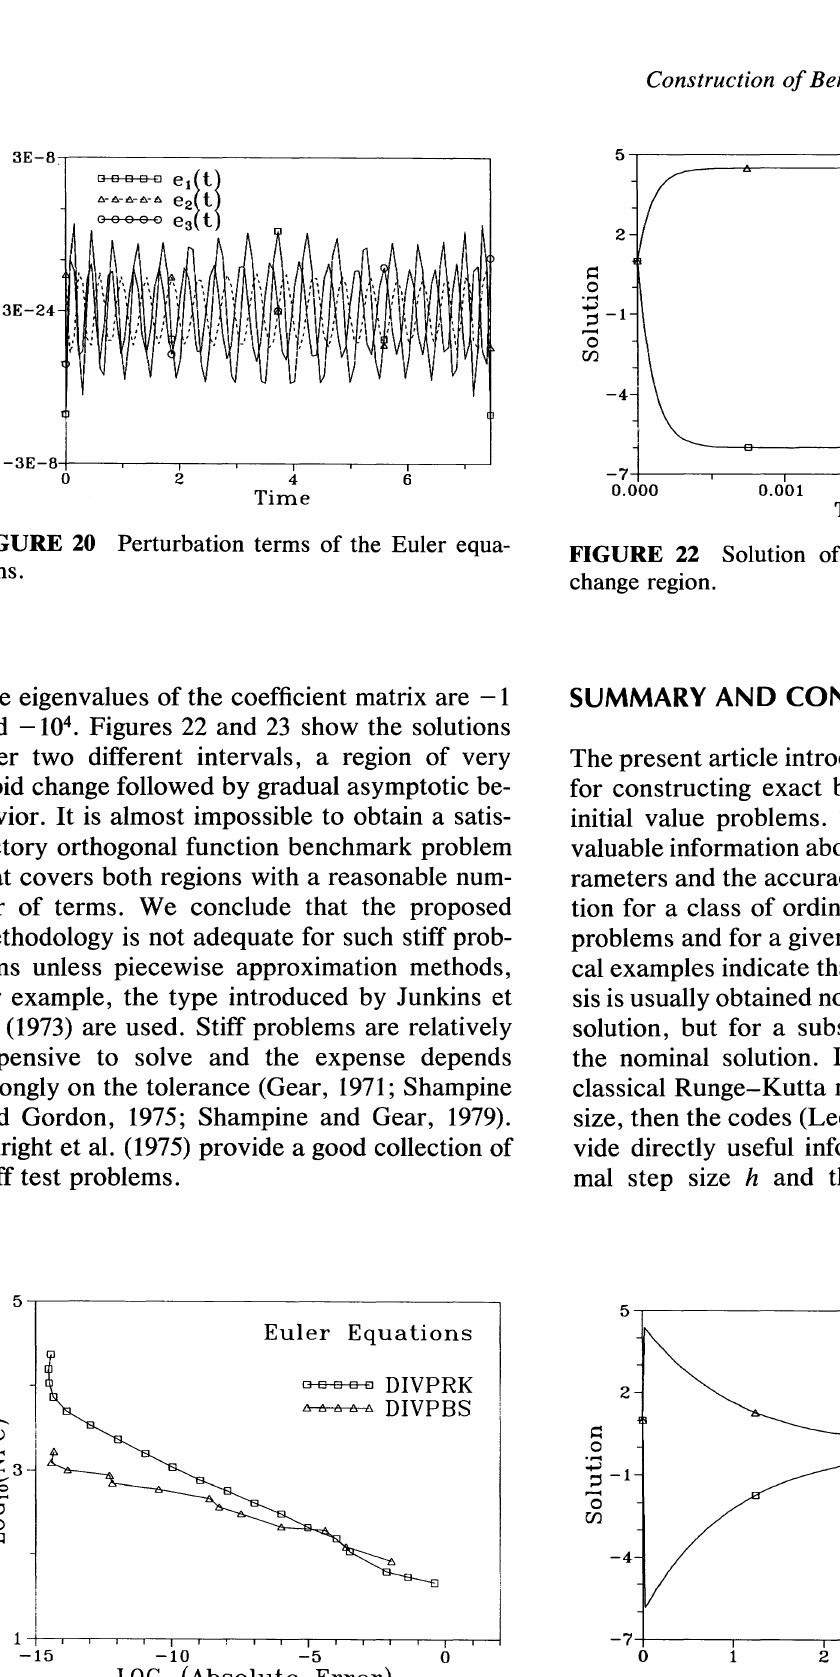
FIGURE 21 Number of function calls vs. absolute error.